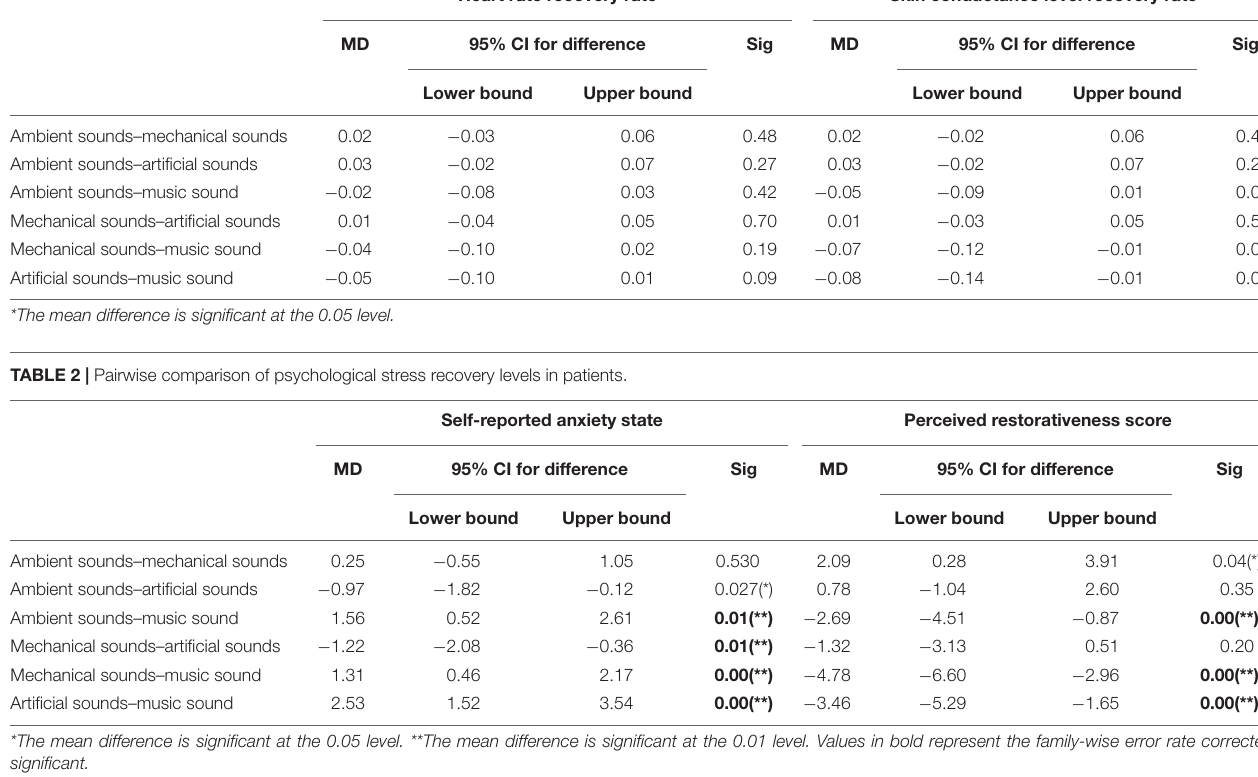
The environmental restorativeness scores given by patients significantly differed ( F = 9.39, Sig = 0.00) under the ambient noise, mechanical noise, artificial, and music soundscape conditions. The effect size (partial η 2 = 0.23) suggested the